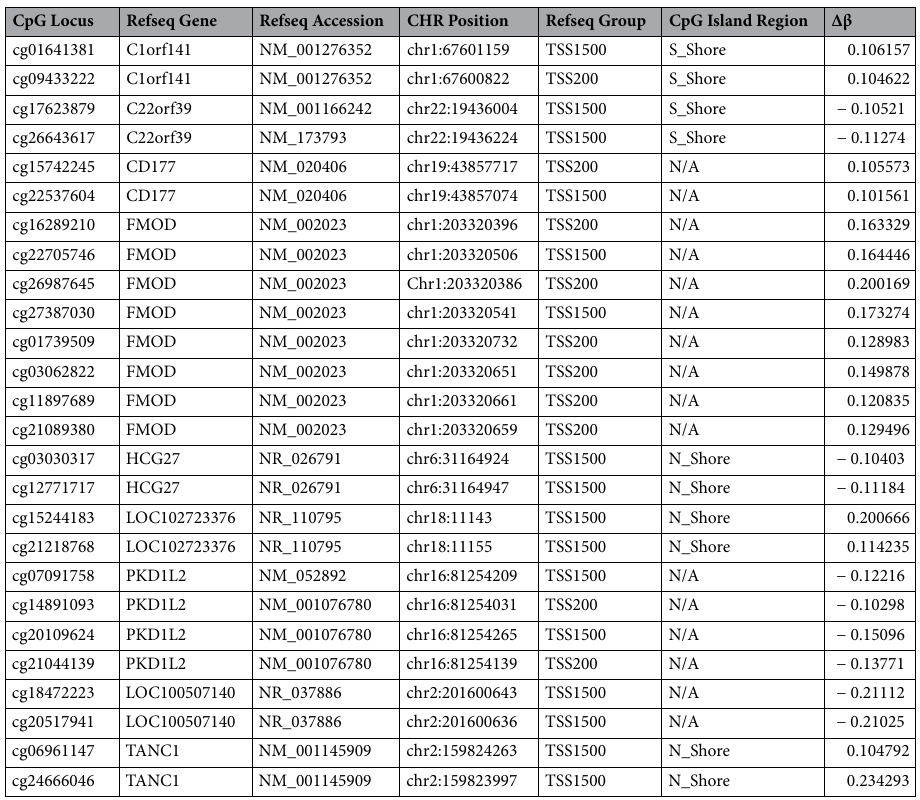
Table 2. Candidate differentially methylated sites identified between cases and controls. Δβ = mean β value (case) − mean β value (control). TSS, transcription start